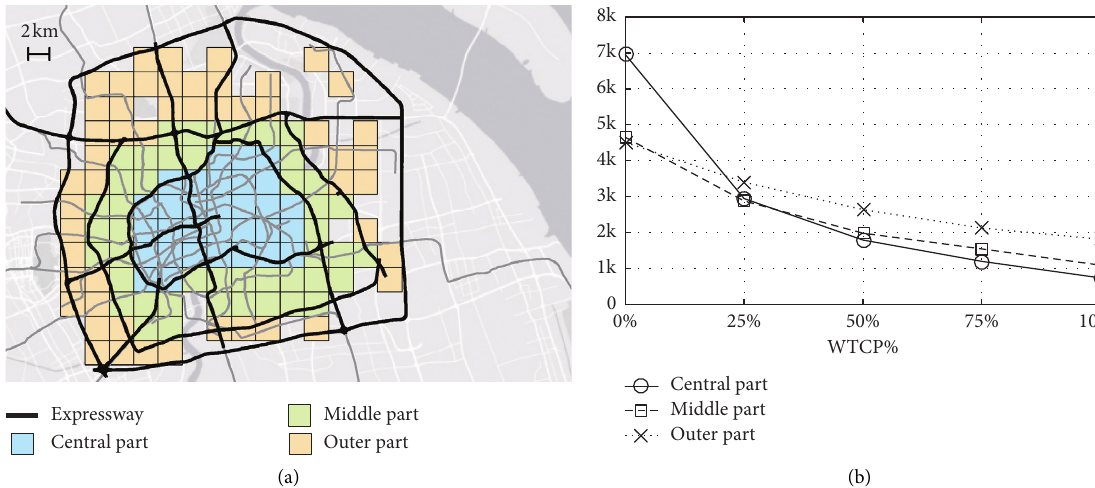
Figure 10: Truck flow of different parts of Shanghai. (a) Study area divided into three parts and (b) truck flow (in- and out-flow) of each